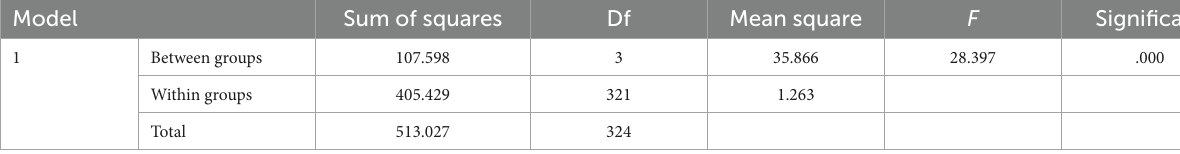
TABLE 9 ANOVA a analysis.